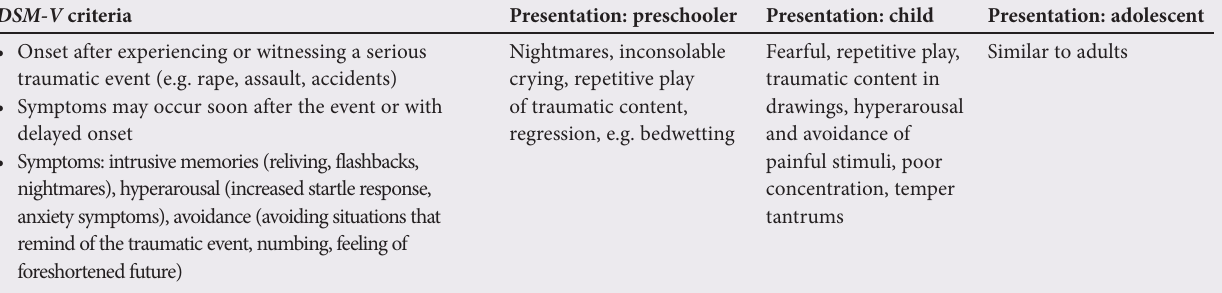
Table 8. PTSD criteria in children and adolescents DSM-V